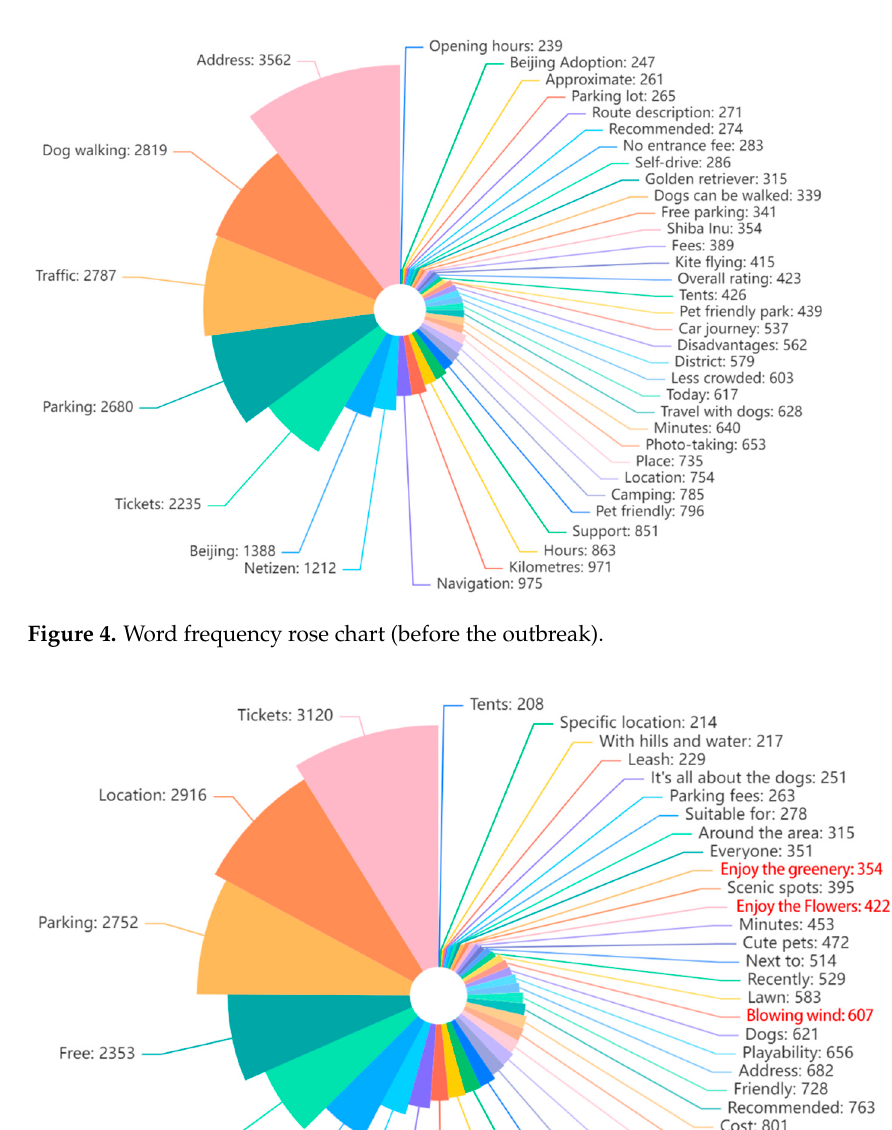
Figure 3. Perceptive word cloud map (during the outbreak).